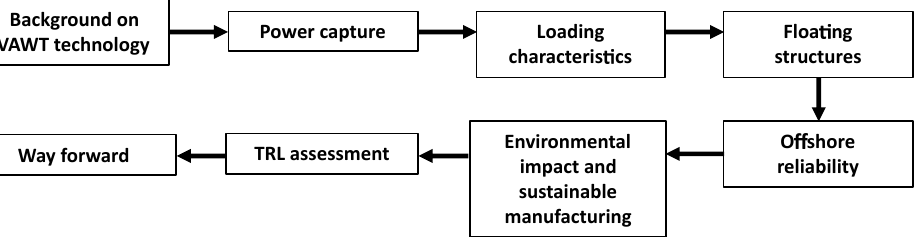
Figure 1. Flowchart of review showing the main blocks on: background on VAWT technology, power capture, loading characteristics, floating structures, offshore reliability, environmental impact and sustainable manufacturing, TRL assessment and way